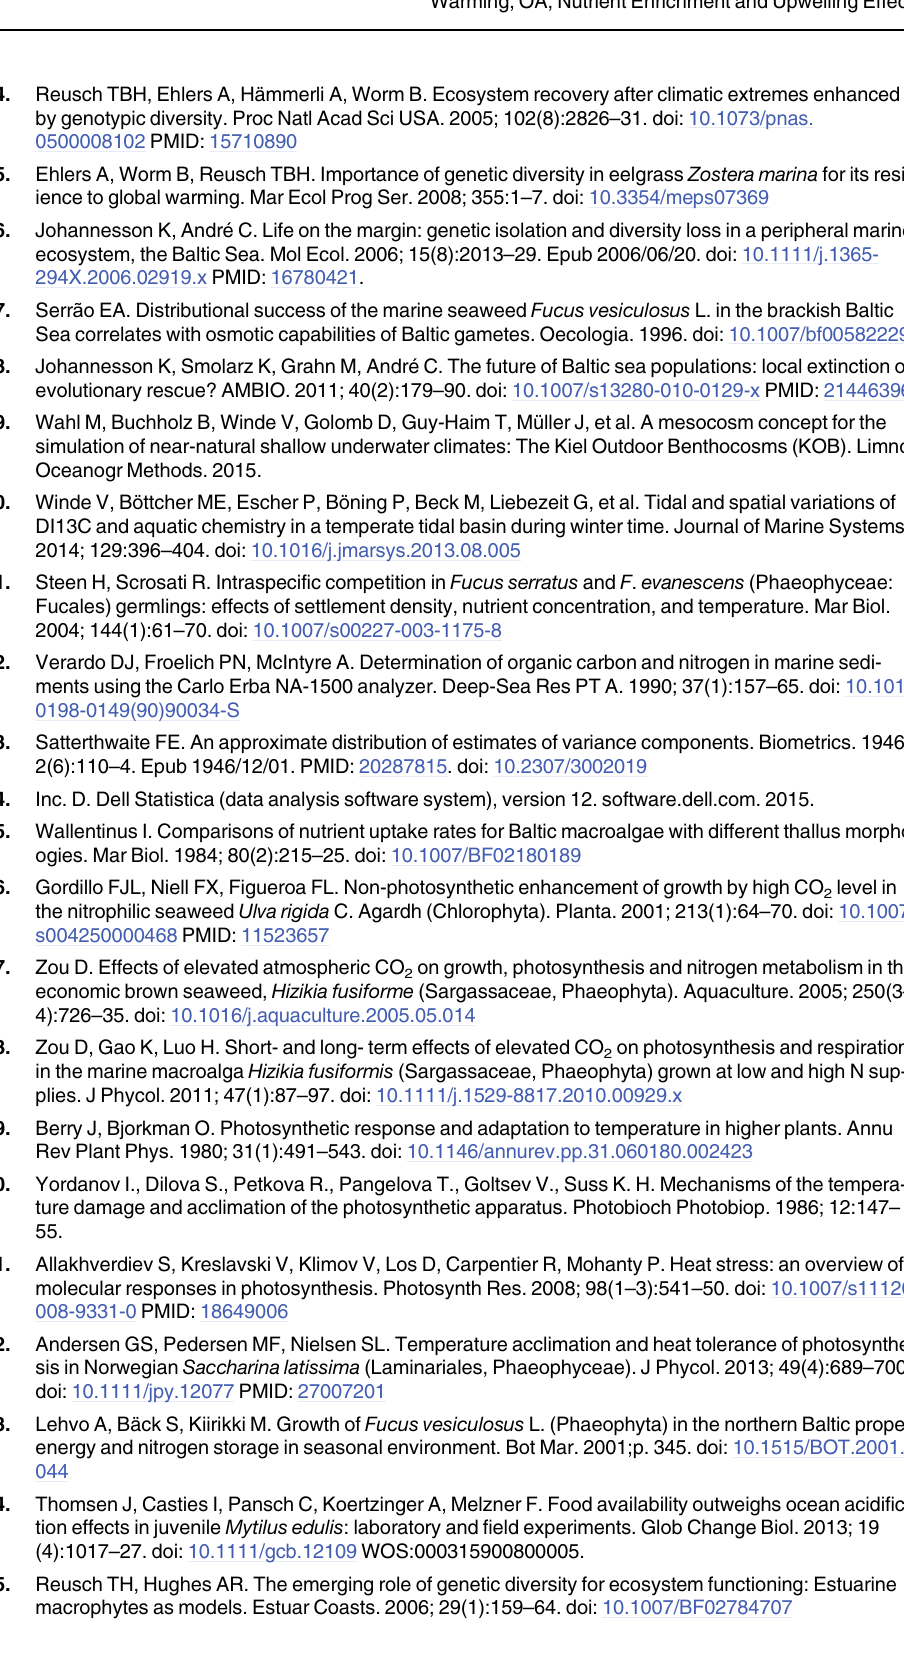
PLOS ONE | DOI:10.1371/journal.pone.0152948 April 4,